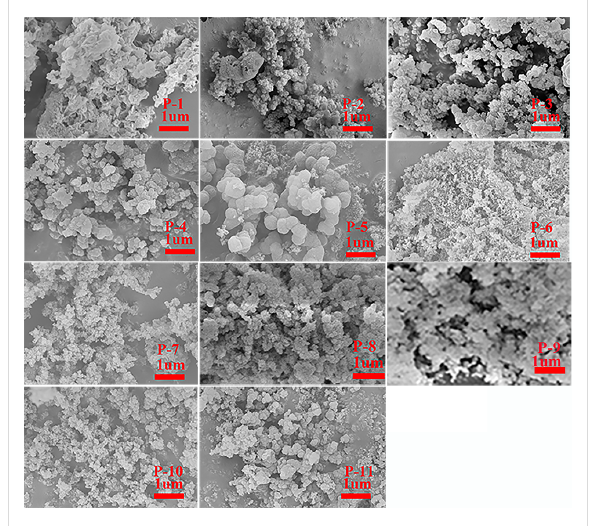
Figure 4: Scanning Electron micrograph of